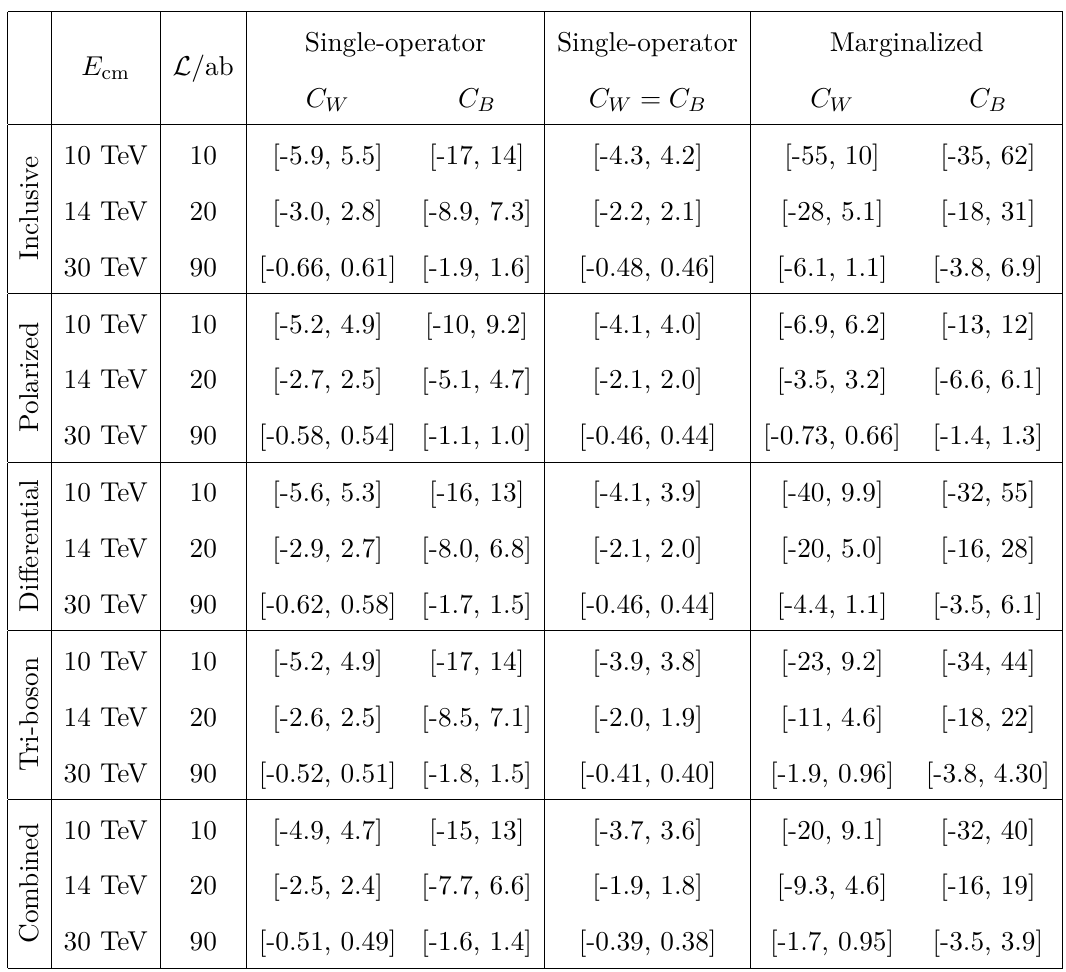
Table 4 . 95% C.L. constraints on C W and C B , expressed in units of (100 TeV) − 2 , for the benchmark VHEL energies and luminosities. The first two columns show the constraints on one coefficient setting the other to zero, the third one is the constraint in the direction C W = C B . The last two columns show the constraints marginalized in the ( C W , C B )